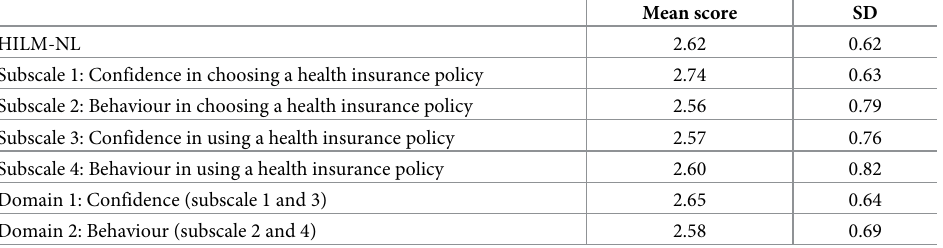
Table 2. The mean score of the HILM-NL and its subscales and domains among the respondents of February 2020 (n = 781).